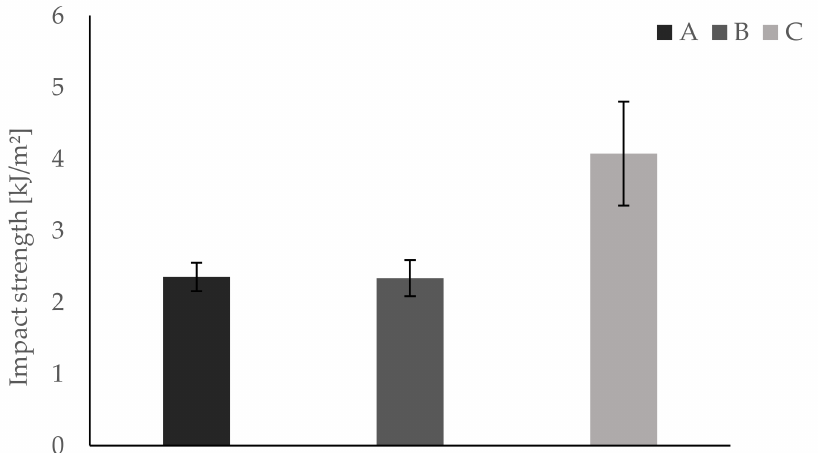
Figure 4. Dynstat impact strength tests show significantly higher impact strength for group C compared to groups A and